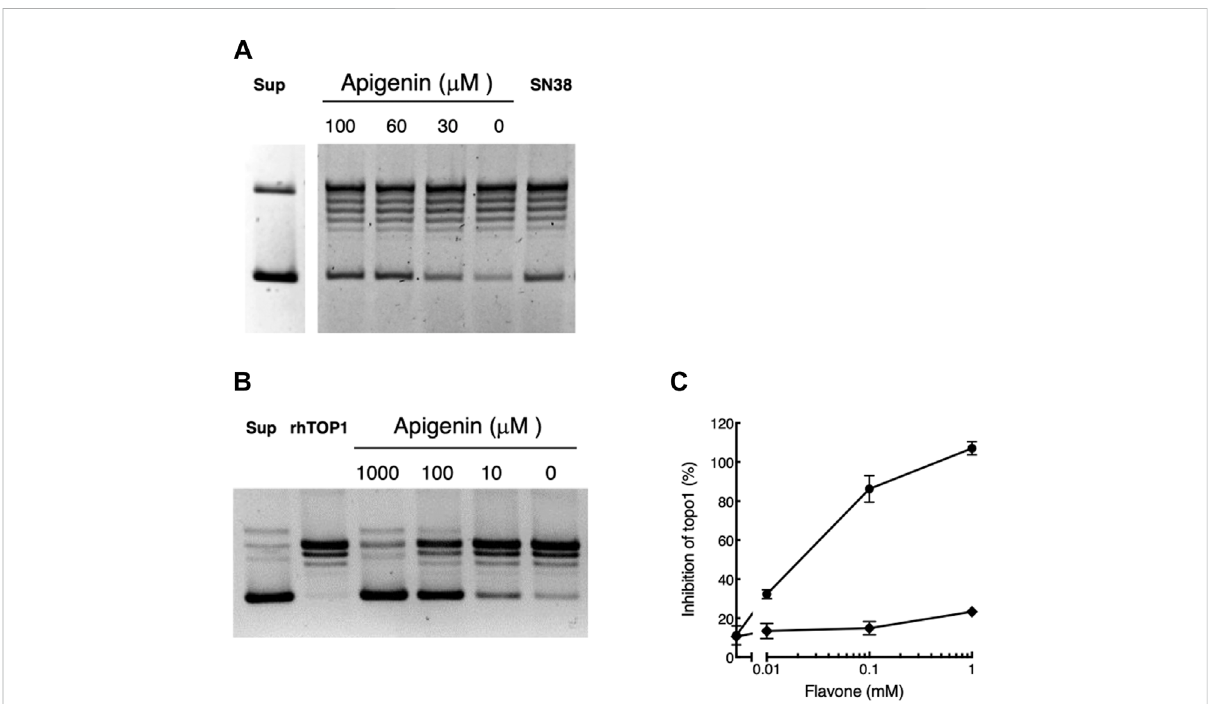
FIGURE 4 Apigenin suppresses topoisomerase 1 activity. (A) Apigenin suppresses topoisomerase 1 activity in whole cells. HT-29 cells were treated with apigeninfor48 hattheconcentrationsindicated.TheoriginalsupercoiledDNAisshown( ‘ Sup ’ )aswellastheeffectoftreatingcellswith30 nMSN38 (positivecontrolfor Topo1inhibition). Thelowest bandisthesupercoiled DNAthatissuccessivelyuncoiled(ladder) bycellularTopo1activitytoyield the fi naluncoiledstructure(topmostband).Maximaluncoilingispresentwithuntreatedcells( “ 0 µMapigenin ” )andthisisinhibitedbyincreasing concentrations of apigenin or exposure to SN38 (more intense lowest band). Representative of three independent experiments. (B) Representative result showing the gel separation of supercoiled plasmid ( “ Sup ” ), the effect of incubation with rhTopo1 alone and the result of co-incubation with apigenin at concentrations shown. As for panel A the lowest band is input supercoiled DNA that shows uncoiling to higher bands in the presence of Topo1,inthiscaserhTopo1.IncreasingconcentrationsofapigeninaddeddirectlytothereactionmixtureinhibitTopo1activity,suchthatat1,000 µM apigenintheuncoilingactivityoftheenzymeisessentiallyblocked. (C) rhTopo1activitywasmeasuredinthepresenceofapigenin( the concentrations shown. Representative of three independent